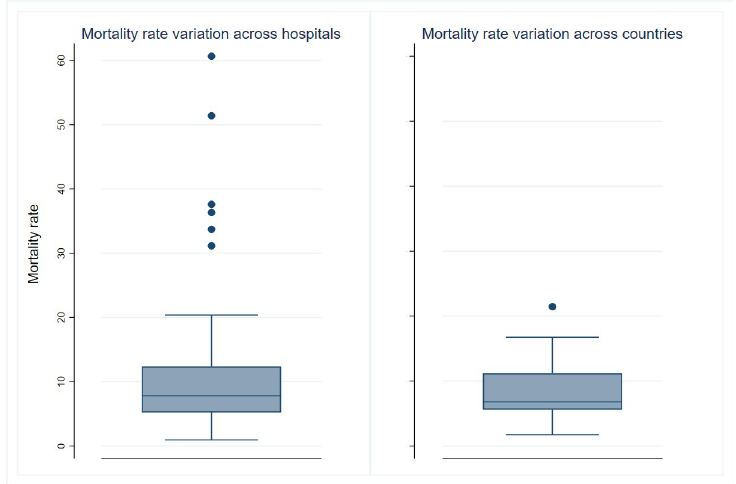
Fig 3. Boxplot of the crude mortality rates per 100-person year across hospitals and